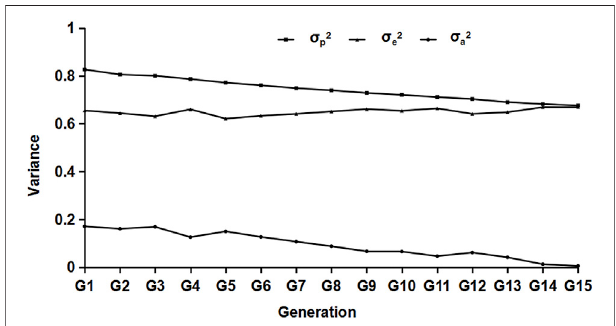
FIGURE 2 | Results of the variance component estimation in different generations. σ p2 , σ a2 , and σ e2 represent the phenotypic, residual, and genetic variances, respectively.